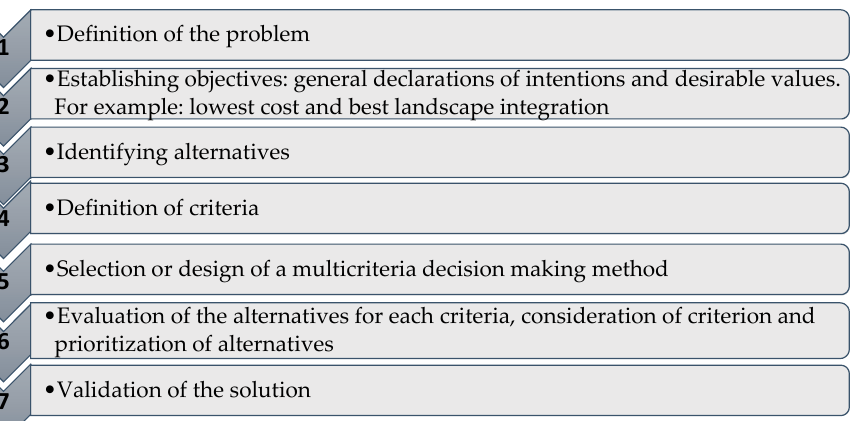
Figure 1. Steps or stages of the decision-making process. Table 2. Selection criteria. Source: the authors’ own